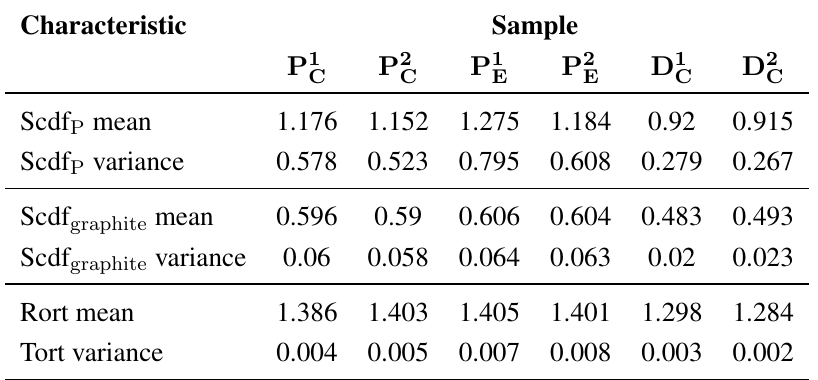
Table 4. Mean and variance of the spherical contact distances for the pore (scdf graphite phase (scdf ) in µm, as well as of the geometric tortuosity (tort) computed for graphite six selected binary images of anode